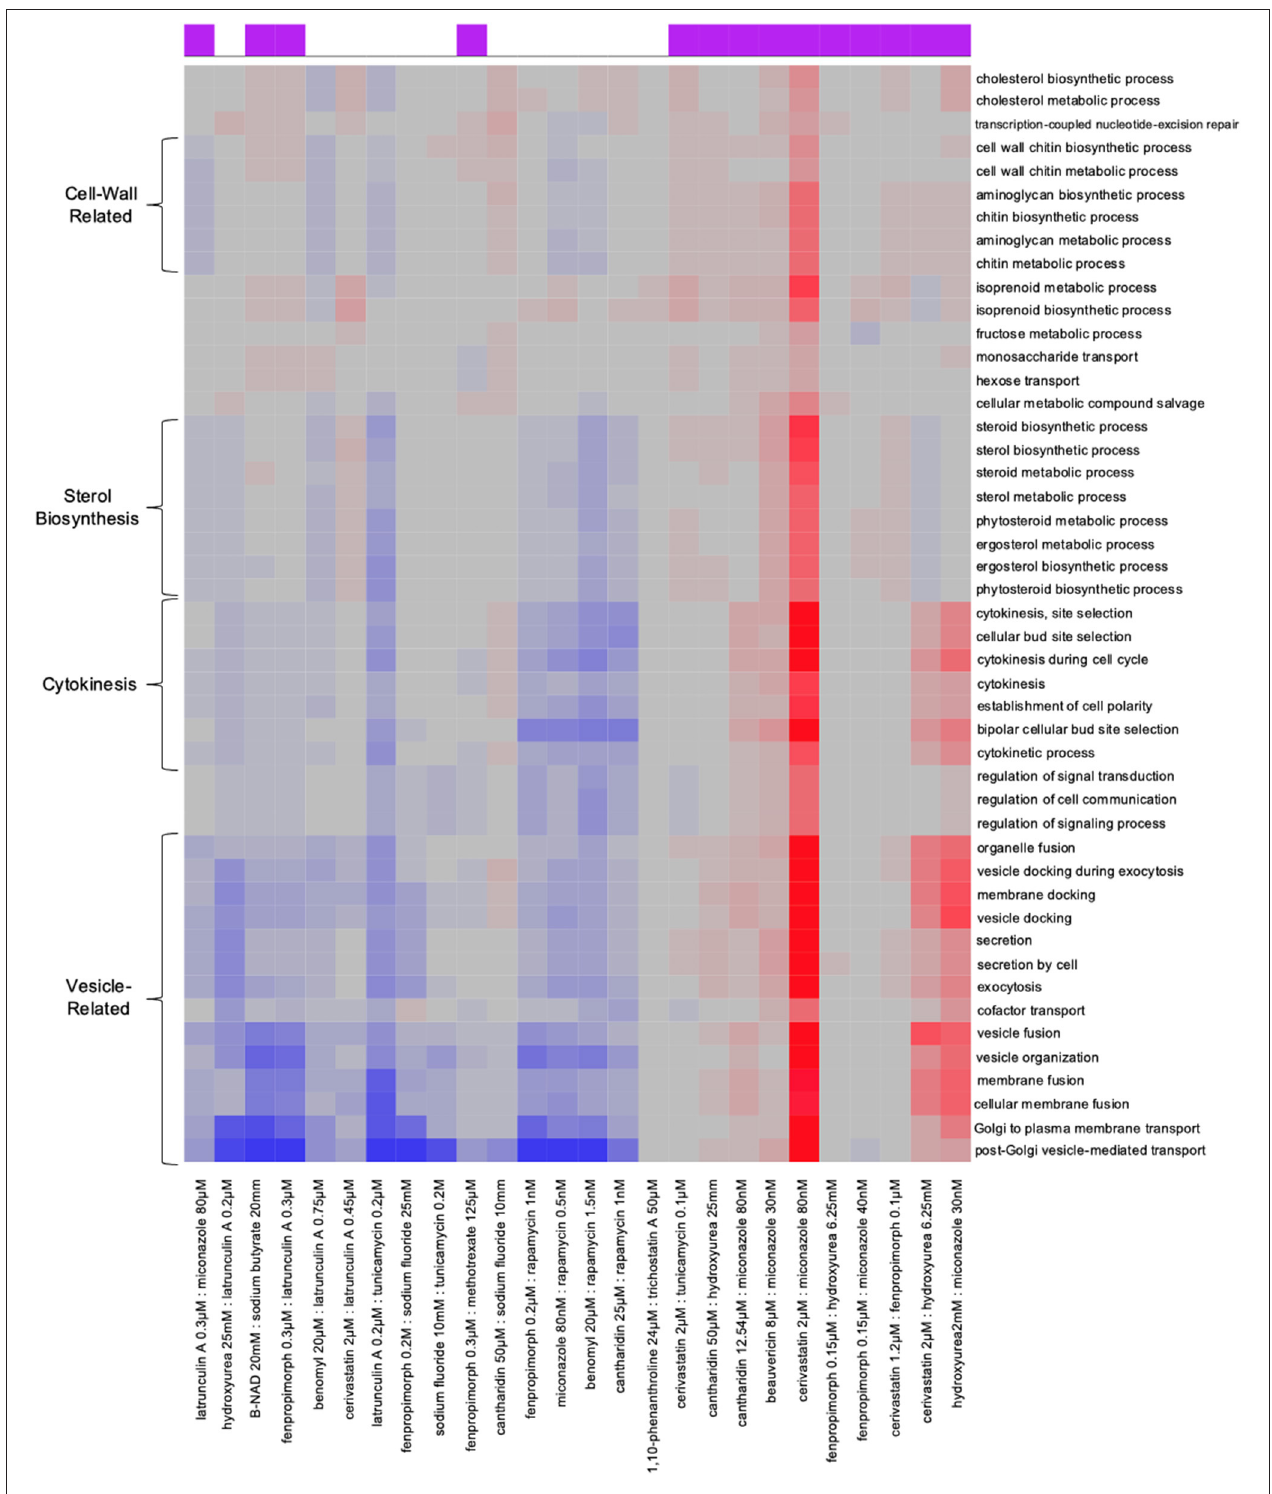
FIGURE 5 | Combination-specific Gene-Ontology (GO) enrichment HIP–HOP data. Examination of Gene-Ontology enrichment using ε score. In the clustered heat map generated from the ε scores, on the x-axis we have each drug combination listed on the bottom; at the top on the x-axis is a purple box which denotes if a combination is synergistic or not. GO terms are denoted on the y-axis. Red shows a particular GO term is highly enriched in the combination, gray denotes no enrichment, and blue shows significant enrichment among genes with low ε scores.